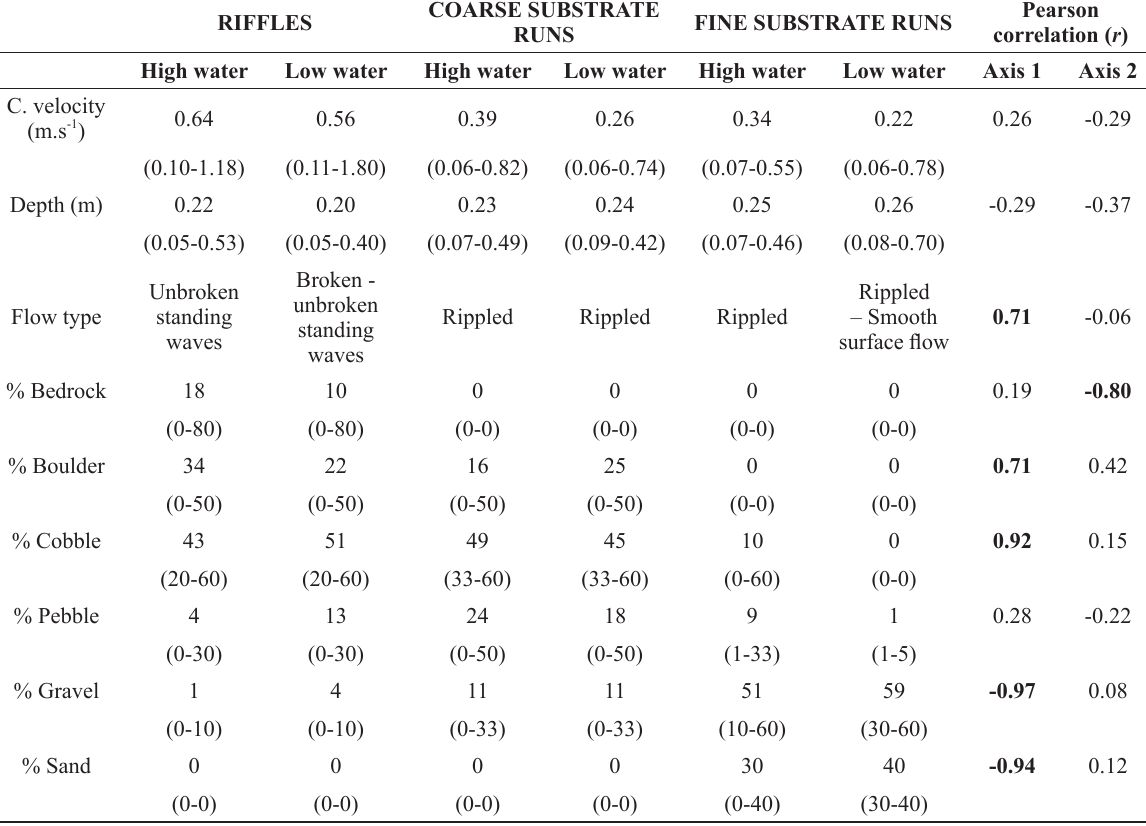
Characterization of habitat types sampled during low and high water periods and Pearson’s correlation coefficients between habitat variables and principal component analysis (PCA) axes scores (Values ≥ 0.6 are in bold). Mean values of habitat variables are shown with the corresponding minimum and maximum value